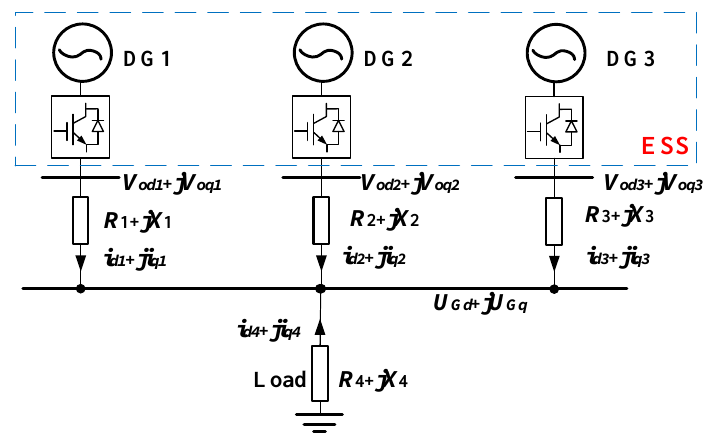
Figure 1. System model of microgrid (MG) with multiple master–slave control method.